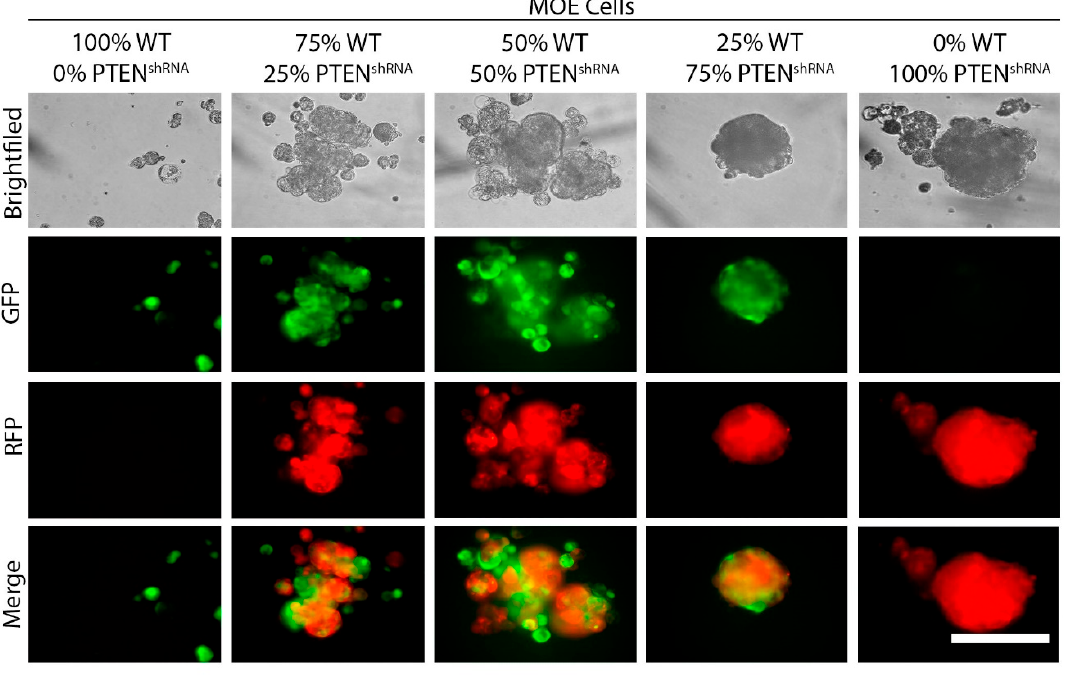
Figure 3. MTS formed by MOE PTEN shRNA cells are able to incorporate some wild type (WT) MOE cells, but too many wild type cells prevents MTS formation. Representative images of structures formed with MOE wild type cells tagged with green fluorescent protein (GFP) and MOE PTEN shRNA cells tagged with red fluorescent protein (RFP) were mixed at indicated ratios and cultured under ULA conditions for seven days. n = 3. Scale bar = 250 μ m.